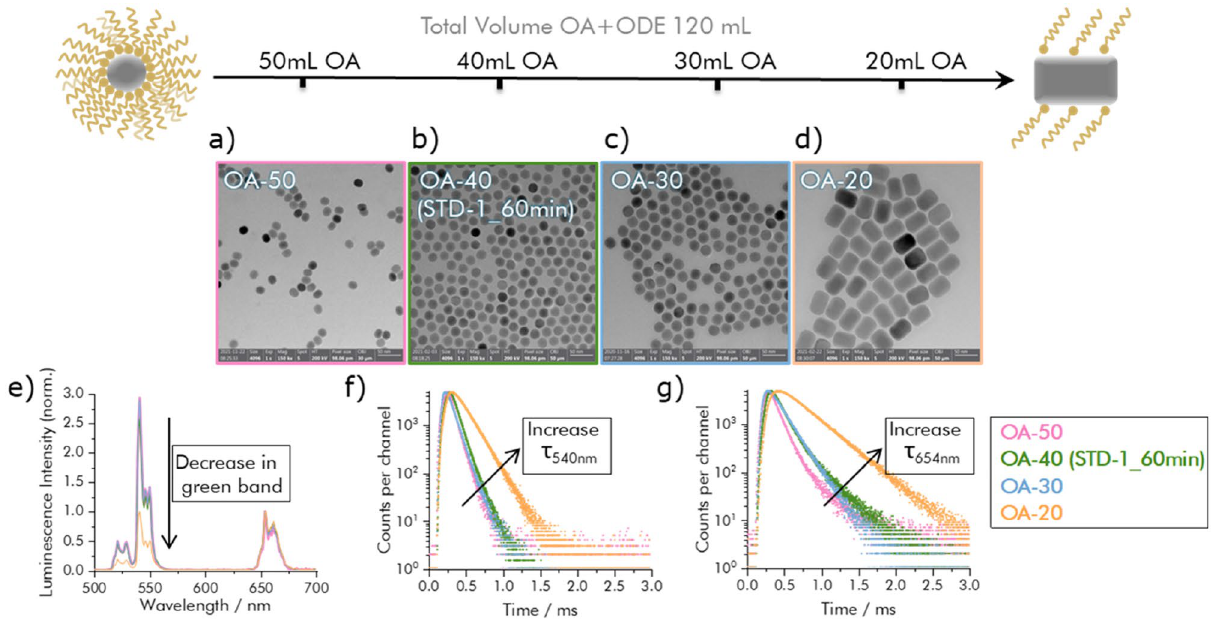
Figure 3. ( a – d ) TEM images of NaYF 4 : 2% Er 3+ , 20% Yb 3+ synthesized using the following reaction conditions: 50 mL OA, 40 mL OA, 30 mL OA, and 20 mL OA (for TEM images with higher resolution: see SI, Fig. S1k,p–r; ( e ) UCL spectra of the resulting UCNPs, excited at 980 nm; ( f ) Decay kinetics of the 540 nm Er 3+ emission; ( g ) Decay kinetics of the 654 nm Er 3+